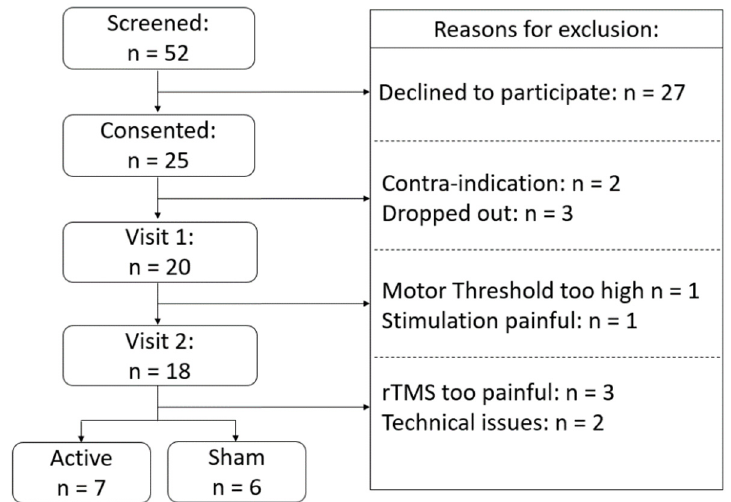
Figure 1. Consort diagram showing the recruitment, exclusion and inclusion numbers.